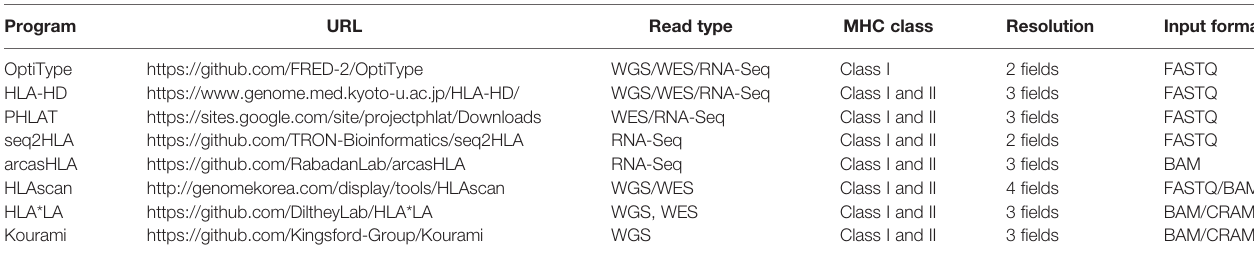
TABLE 1 | Overview of